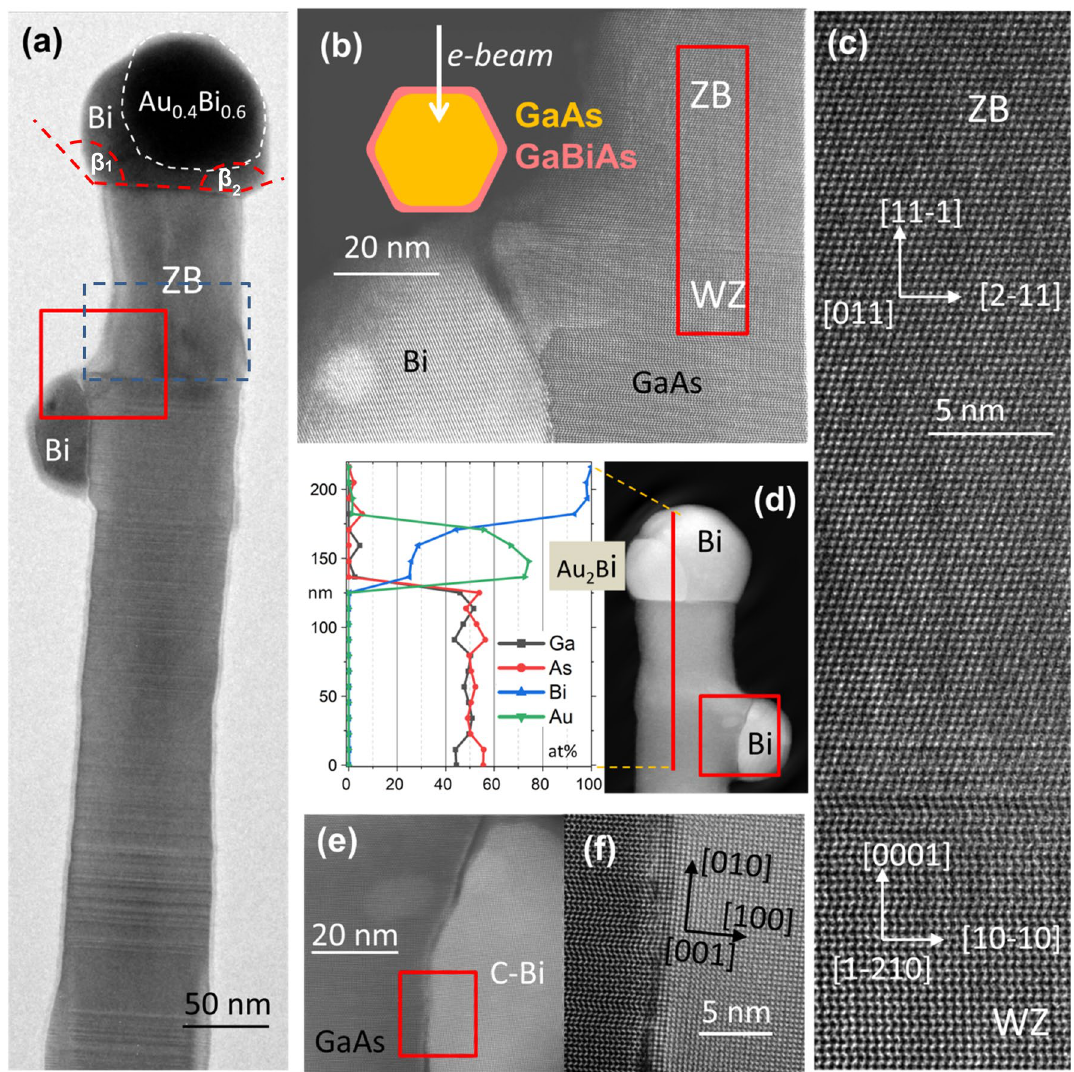
Figure 3. ( a ) HRTEM of a NW from sample 2; ( b ) STEM of the frame in ( a ), a diagram shows orientation of the facets in relation to the e-beam; ( c ) STEM of the frame in ( b ); ( d ) STEM image of another NW and EDS elemental concentration profile along the red line; ( e ) STEM zoomed part of the frame from ( d ); ( f ) zoomed part of the frame marked in ( e